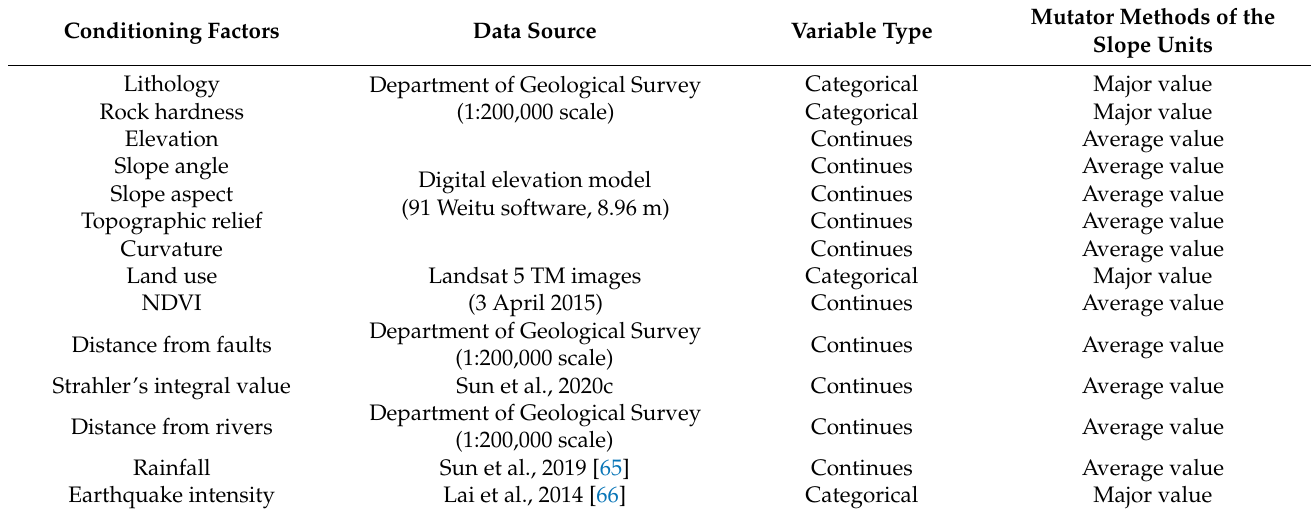
Table 1. Landslide conditioning factors in the present